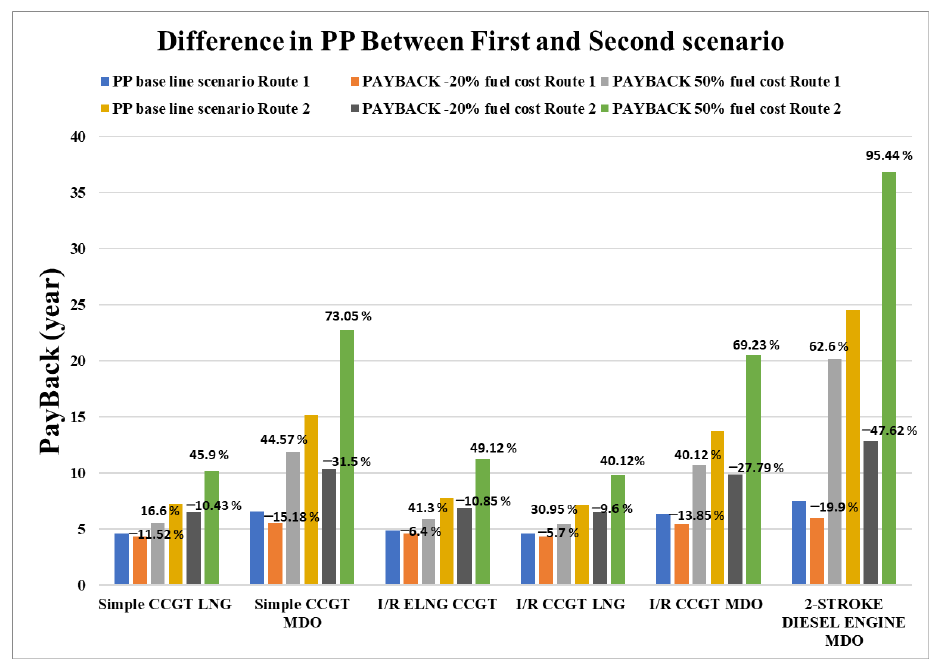
Figure 5. Difference in PP between the first and second scenarios for Routes 1 and 2.